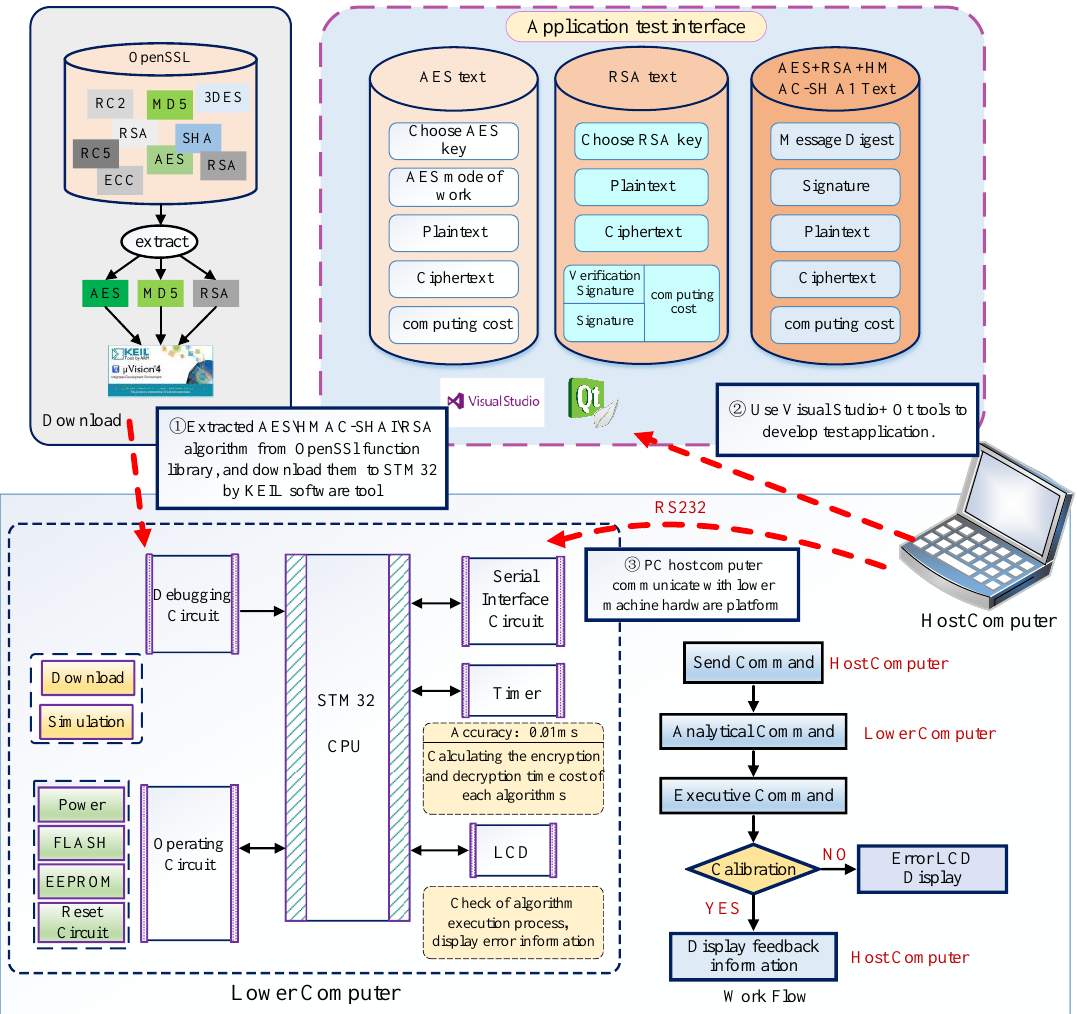
Figure 8. Test equipment diagram.